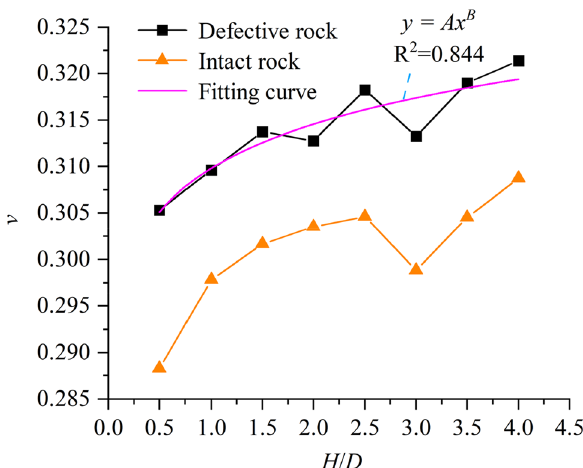
Figure 13. Relationship between Poisson’s ratio and aspect